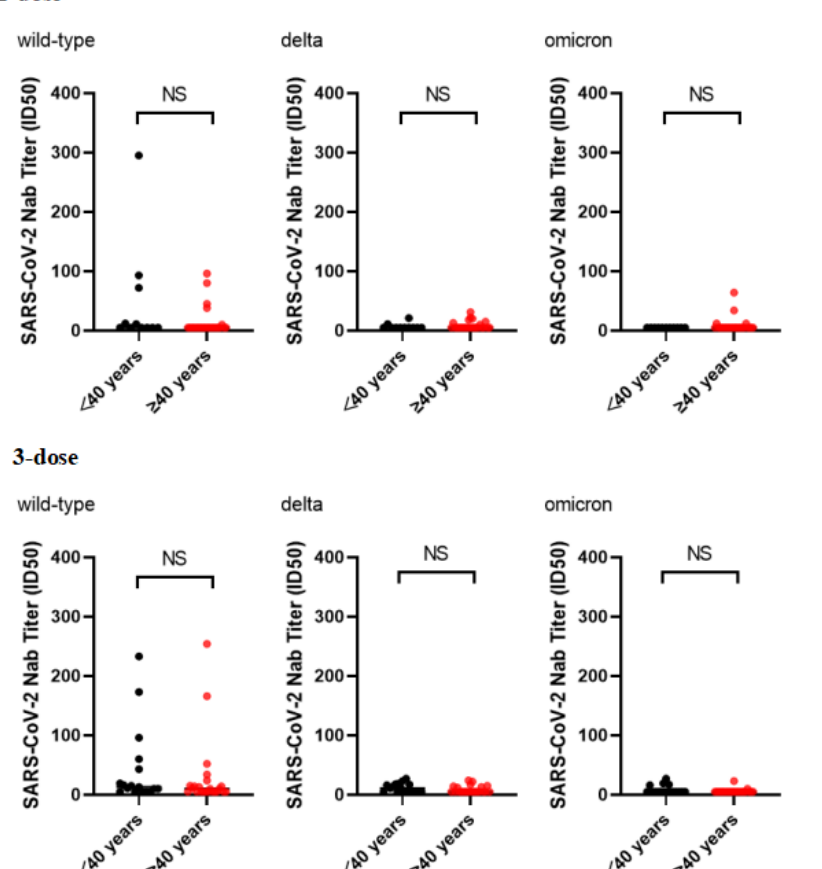
Figure 3. Subgroup analysis. ( A ) Time interval after vaccination was divided at 3 months (<3 months and ≥ 3 months). Neutralizing Ab response to wild-type, Delta, and Omicron strains in two- or three-dose vaccine recipients in different time intervals groups. ( B ) Age was divided at 40 years (<40 and ≥ 40 years). Neutralizing Ab response to wild-type, Delta, and Omicron strains in two- or three-dose vaccine recipients in different age groups. NS: not statistically significant.